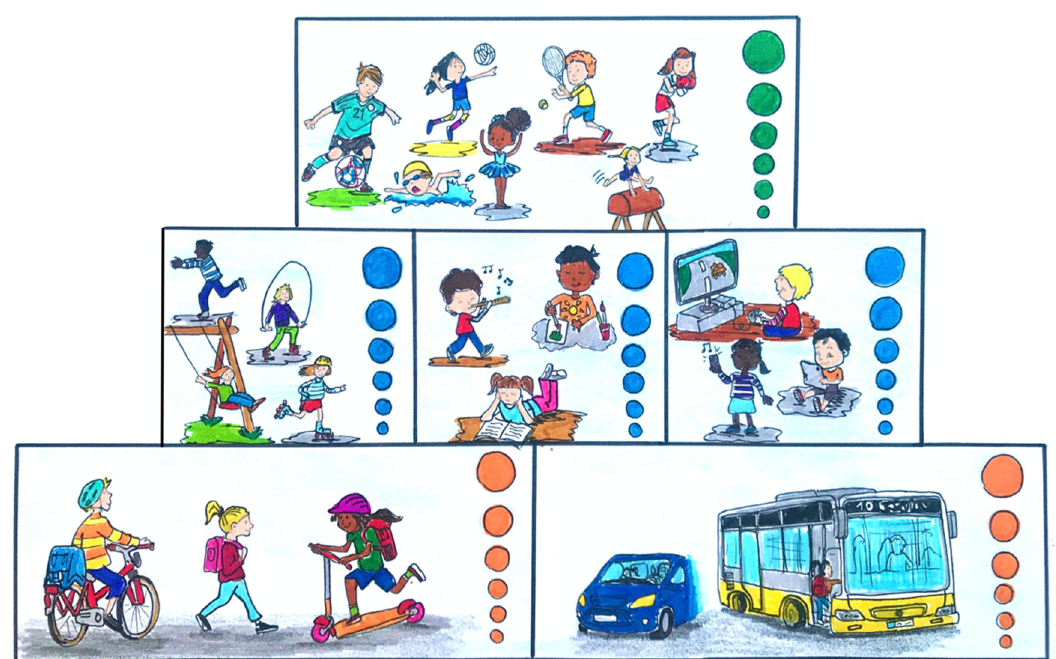
Figure 2. Activity pyramid to measure participation: lower level—everyday life (left active = light intensity, right inactive); middle level—leisure time (left active = moderate intensity, middle non- medial, right digital); upper level—sports = high